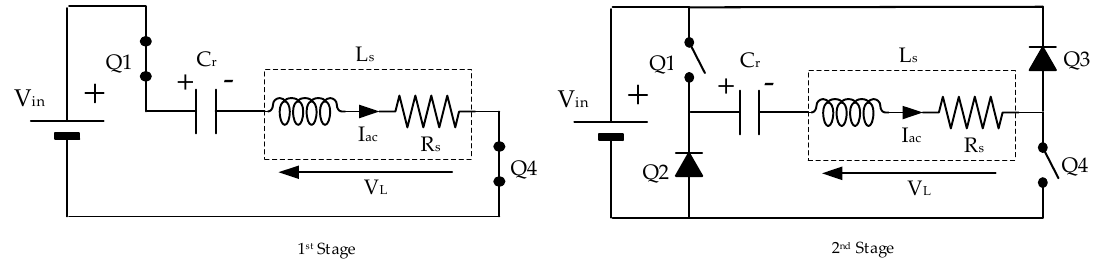
Figure 10. First two stages during the pulse generation .